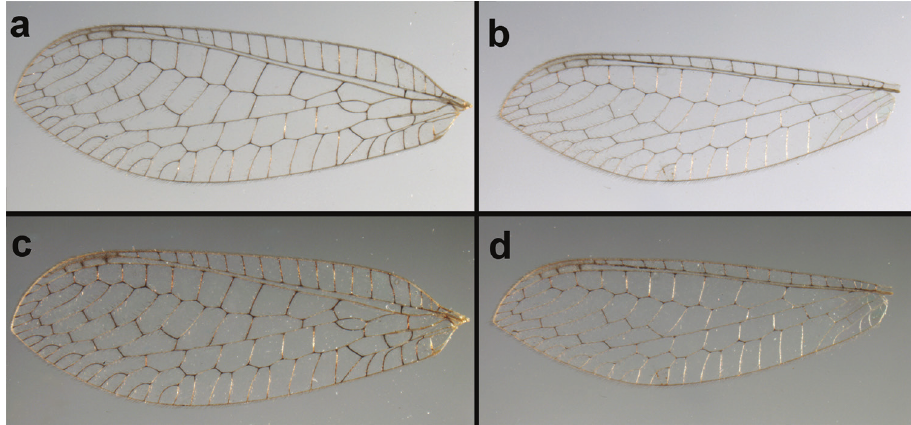
Figure 86. Ungla siderocephala (Navás): Wings, ( a, b ) venation emphasized ( c, d ) coloration of veins emphasized (all: Peru, La Samme, female, CAS).